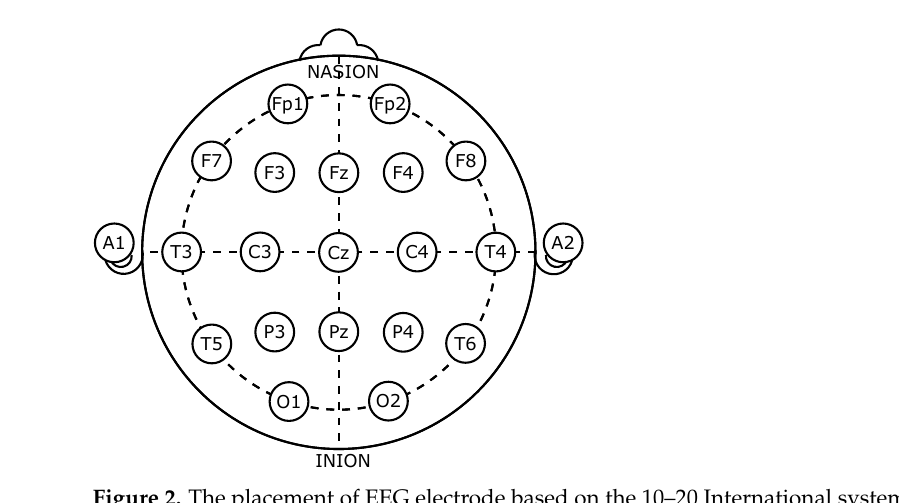
Figure 2. The placement of EEG electrode based on the 10–20 International